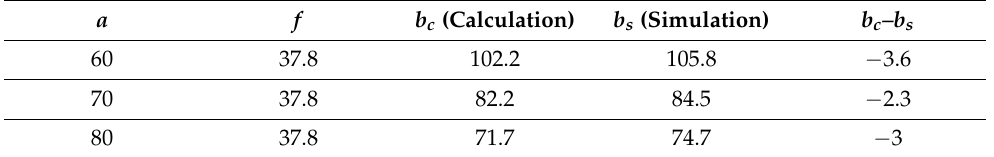
Table 1. Factors of the optical system ( µ